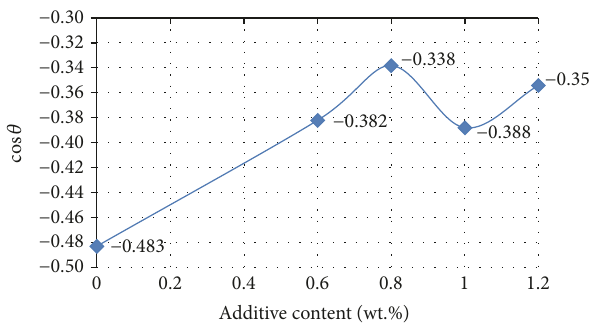
Figure 5: Dependence of the glass surface wetting contact angle on the content of the PFM.